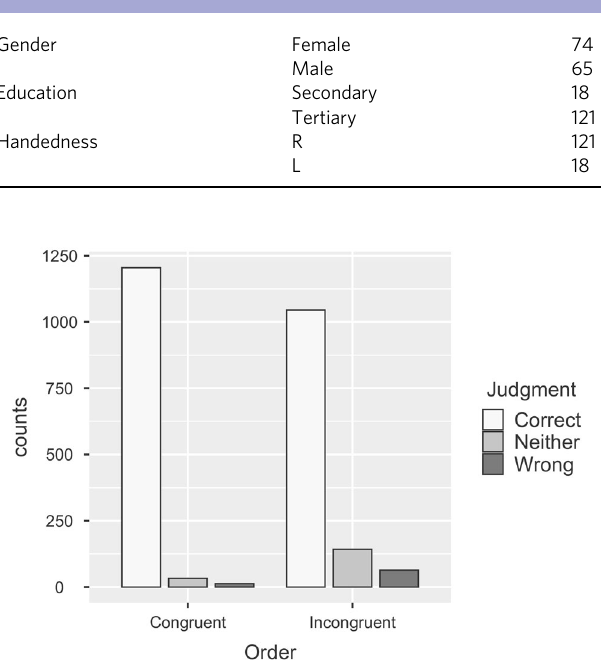
Fig. 1 Judgments split by order. The bars show raw